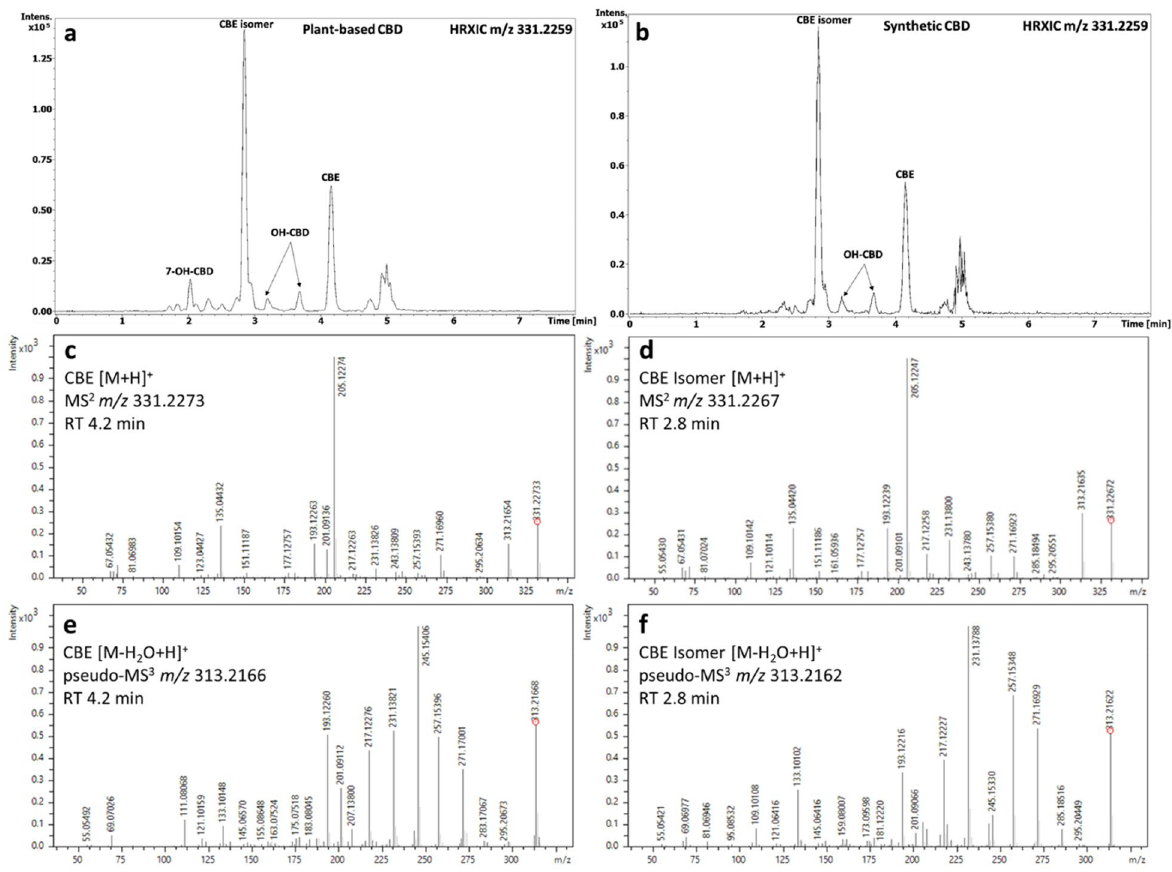
Figure 3. Representative high-resolution extracted ion chromatograms of CBE m/z 331.2259 in CBD e-liquid after 4 weeks of storage at 40 °C and 75% RH. ( a ) Plant-based CBD formulation; ( b ) synthetic CBD formulation. ( c ) MS 2 fragmentation spectrum of CBE. ( d ) MS 2 fragmentation of the m/z 331.2259 ion putatively identified as CBE isomer. ( e ) Pseudo-MS 3 fragmentation of the [M-H 2 O + H] + m/z 313.2166 ion of CBE. ( f ) Pseudo-MS